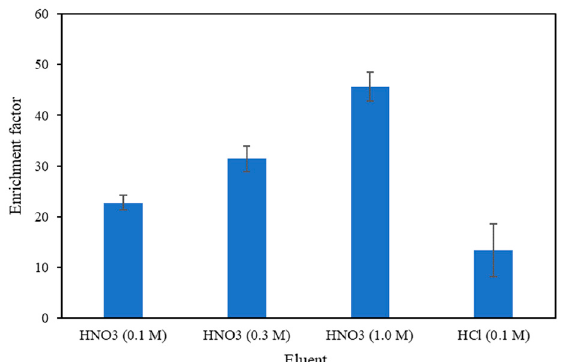
Figure 3. Effect of the desorption agent on the enrichment factor for Pb with magnetite Fe 3 O 4 . Sample: Pb 1 ng·mL − 1 , 100 mL; pH: 5; sorption time (magnetic stirring time): 5 min; desorption: ultrasound; eluent volume: 1 mL.